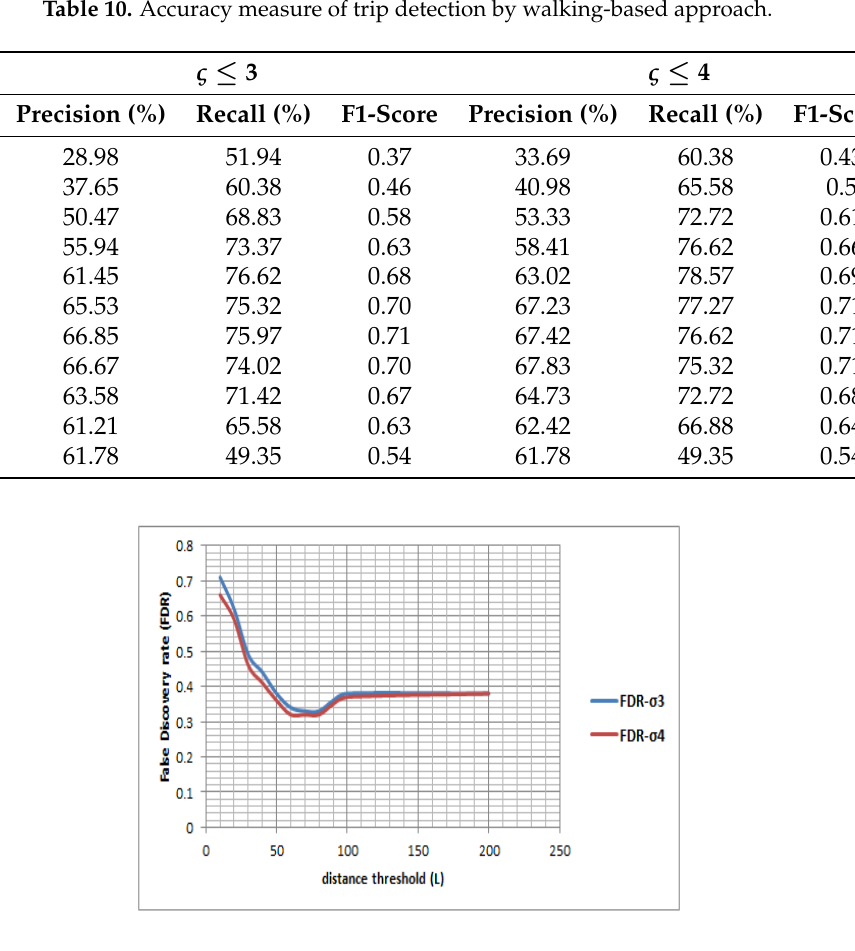
Figure 13. False detection rate (FDR) generated by the walking-based